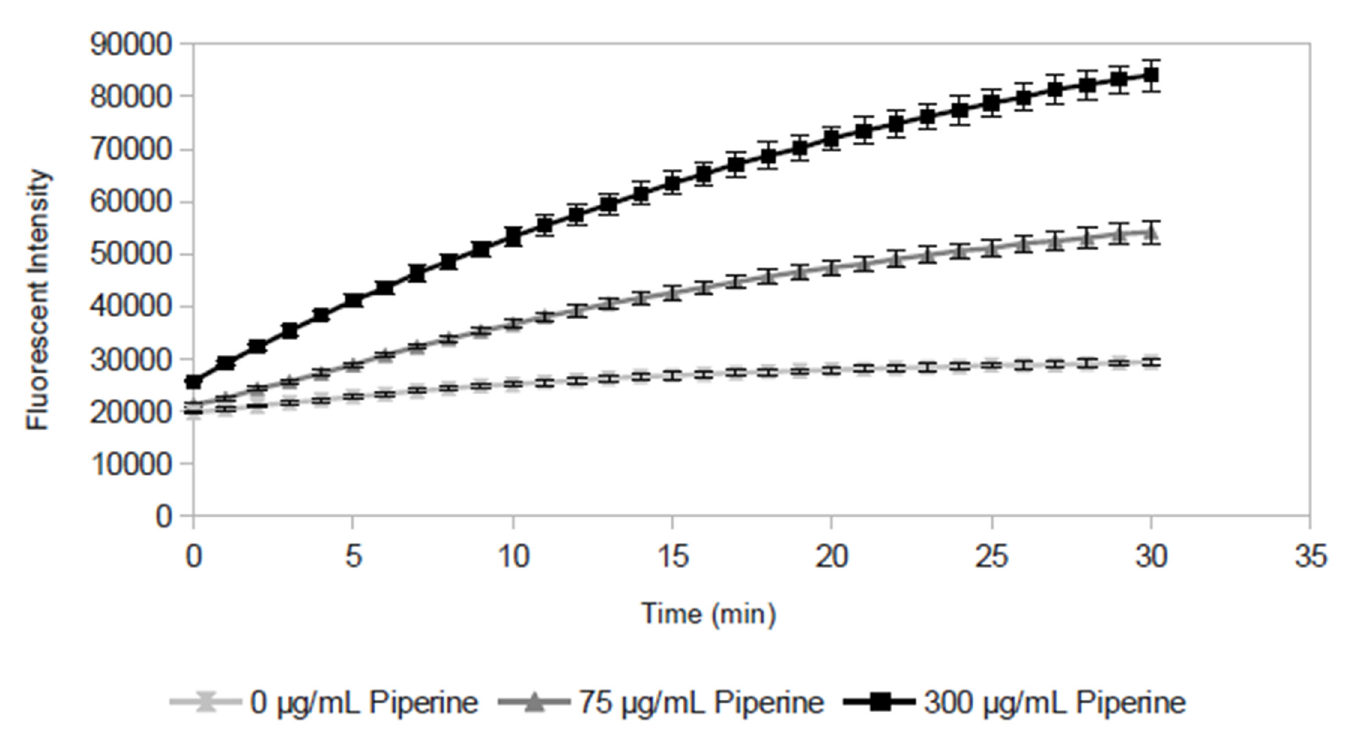
Fig 1. Change in absolute fluorescent intensity over time for Staphylococcus aureus exposed to ethidium bromide in the efflux pump inhibitor piperine. Fluorescence increases over time due to intracellular accumulation of ethidium bromide. The increase is more pronounced in the presence of piperine, which enhances intracellular accumulation of ethidium bromide by blocking efflux. Data points represent the mean of 3 samples, error bars represent standard deviation.